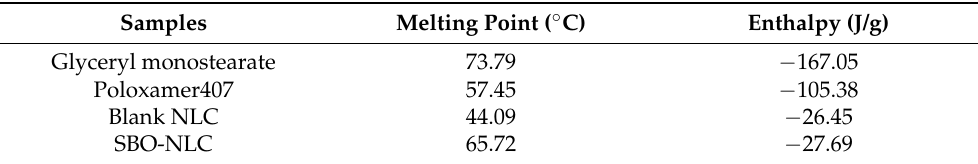
Figure 5. Differential scanning calorimetry thermograms of glyceryl monostearate ( a ), poloxamer 407 ( b ), SBO-NLCs ( c ), and blank NLCs ( d ).